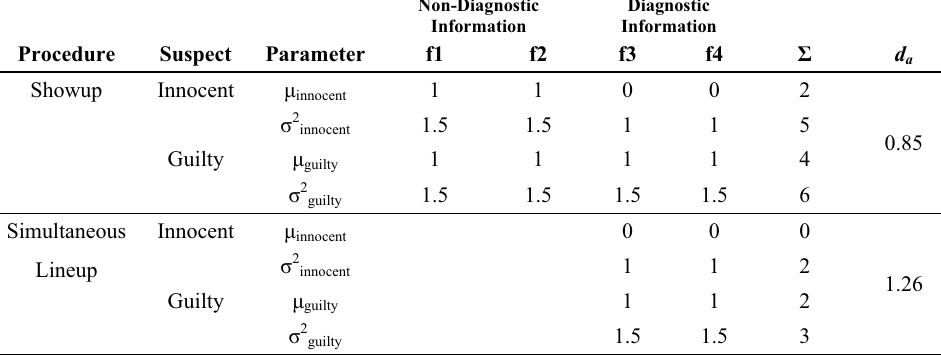
Table 1 Diagnostic feature-detection theory modified from Table 1 of Wixted and Mickes (2014) Non-Diagnostic